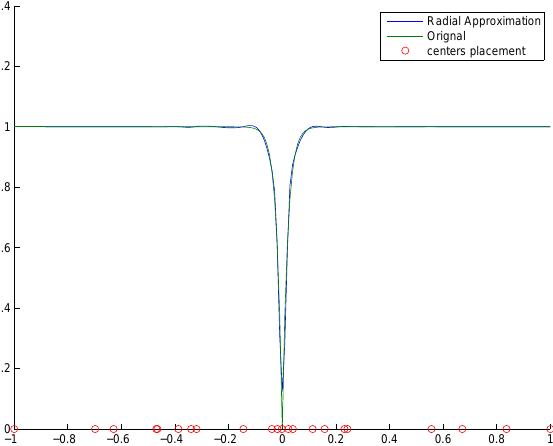
Figure 4. Graphical results for f 3 ( x ) with 20 interior centers (marked on the x